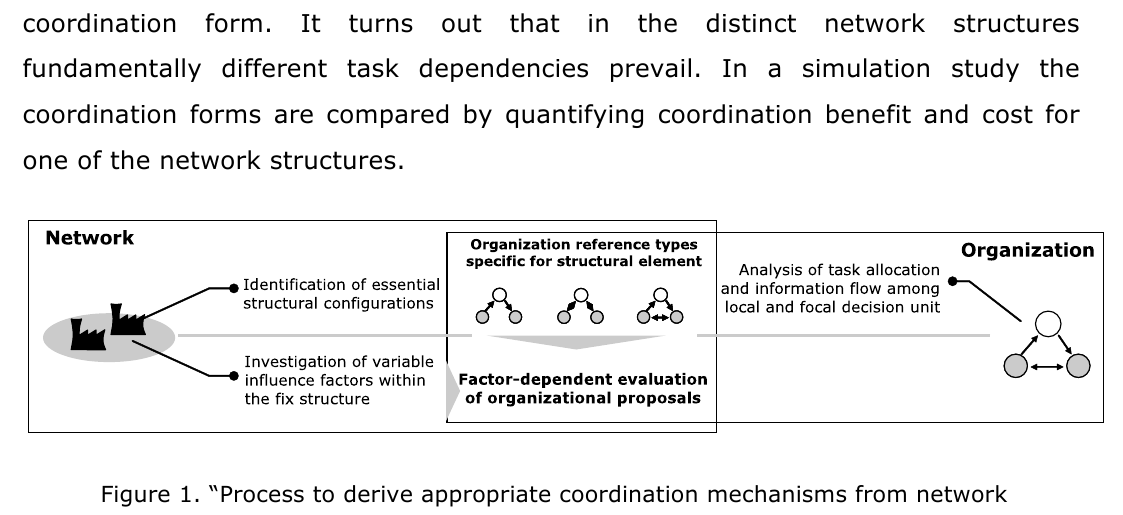
Figure 1. “Process to derive appropriate coordination mechanisms from network